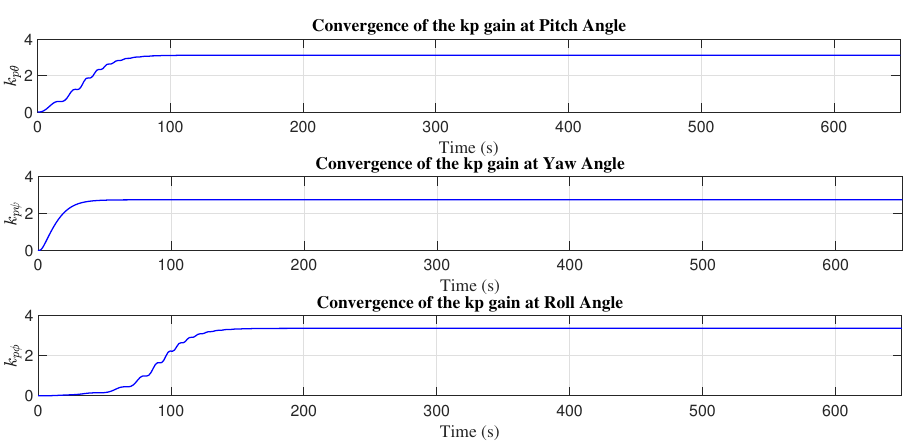
Figure 12. Minimization of J θ , ψ , φ with MIT rule.